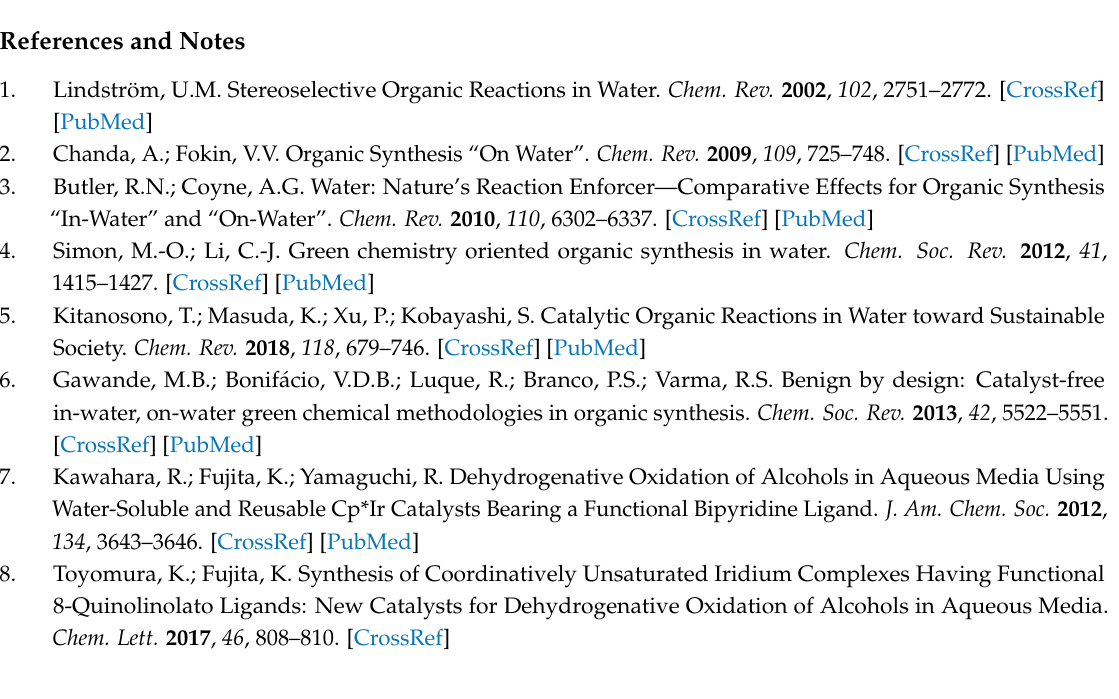
Figure S1. Reaction setup for the quantitative analysis of the evolved hydrogen gas. Figure S2. GC analyses of the hydrogen gas. a) The chromatogram of the evolved gas by the reaction of 1-indanol. b) The chromatogram of the standard gas of pure hydrogen. Figure S3. 1 H NMR(D 2 O) experiment for detection of the active